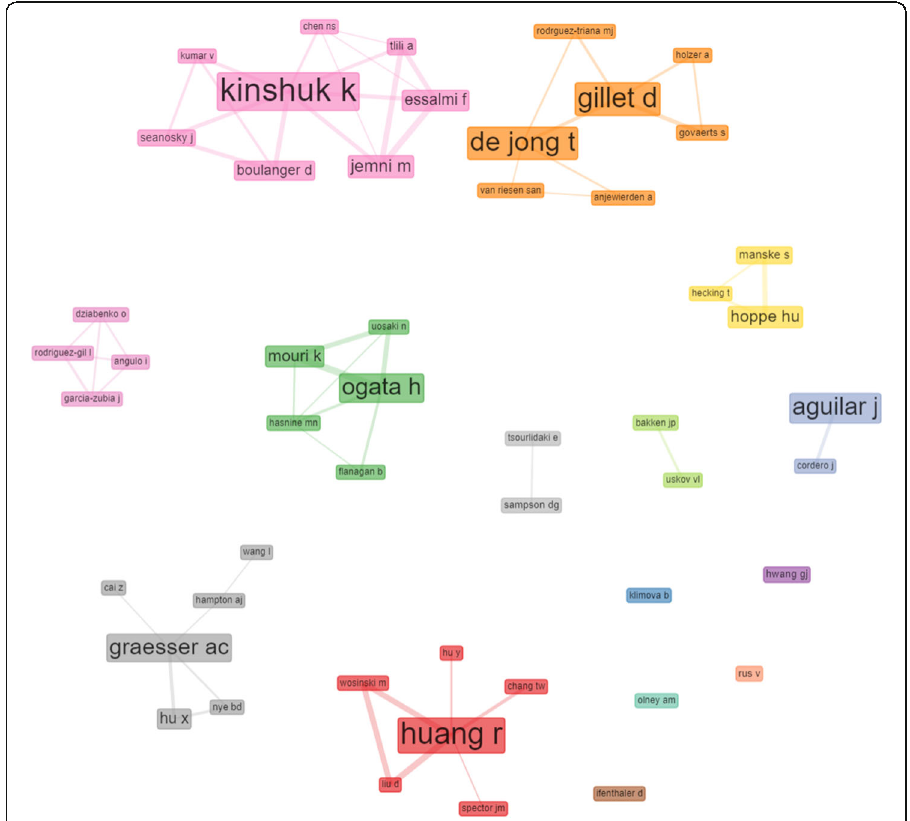
Fig. 6 Mapping of authors ’ collaboration network; Authors ’ names are written in the boxes; the bigger the box, the wider the author ’ s collaboration network; also, there exist networks within a network, e.g., Fathi Essalmi and Mohamed Jemni all connected to